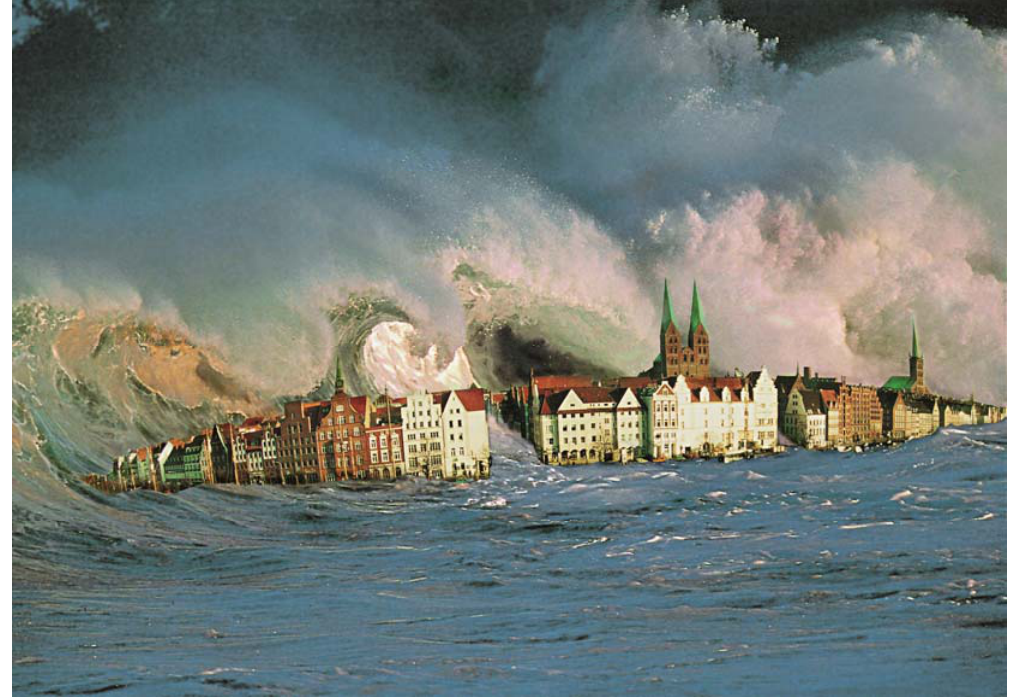
Figure 1. Vulnerability perceptions in Lübeck: the flooding of the old city.